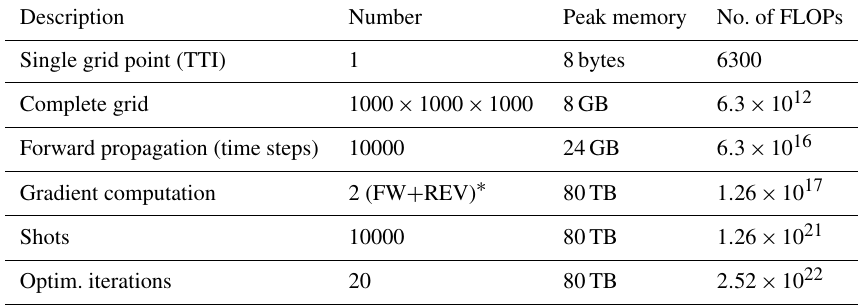
Table 1. Estimated computational requirements of a full waveform inversion problem based on the SEAM model (Fehler and Keliher, 2011), a large-scale industry standard geophysical model that is used to benchmark FWI. Note that real-world FWI problems are likely to be